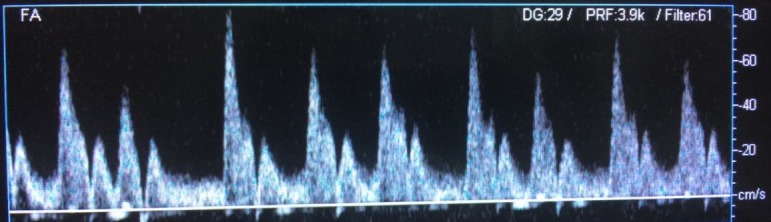
Fibrilação atrial.